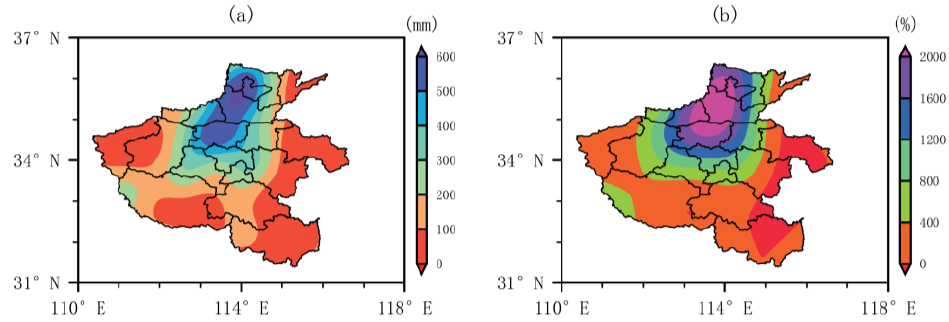
Figure 1. Spatial distribution of rainfall in the Henan Province from 18 to 22 July 2021: ( a ) cumulative rainfall (unit: mm); ( b ) percentage of accumulated rainfall anomaly (unit: %).